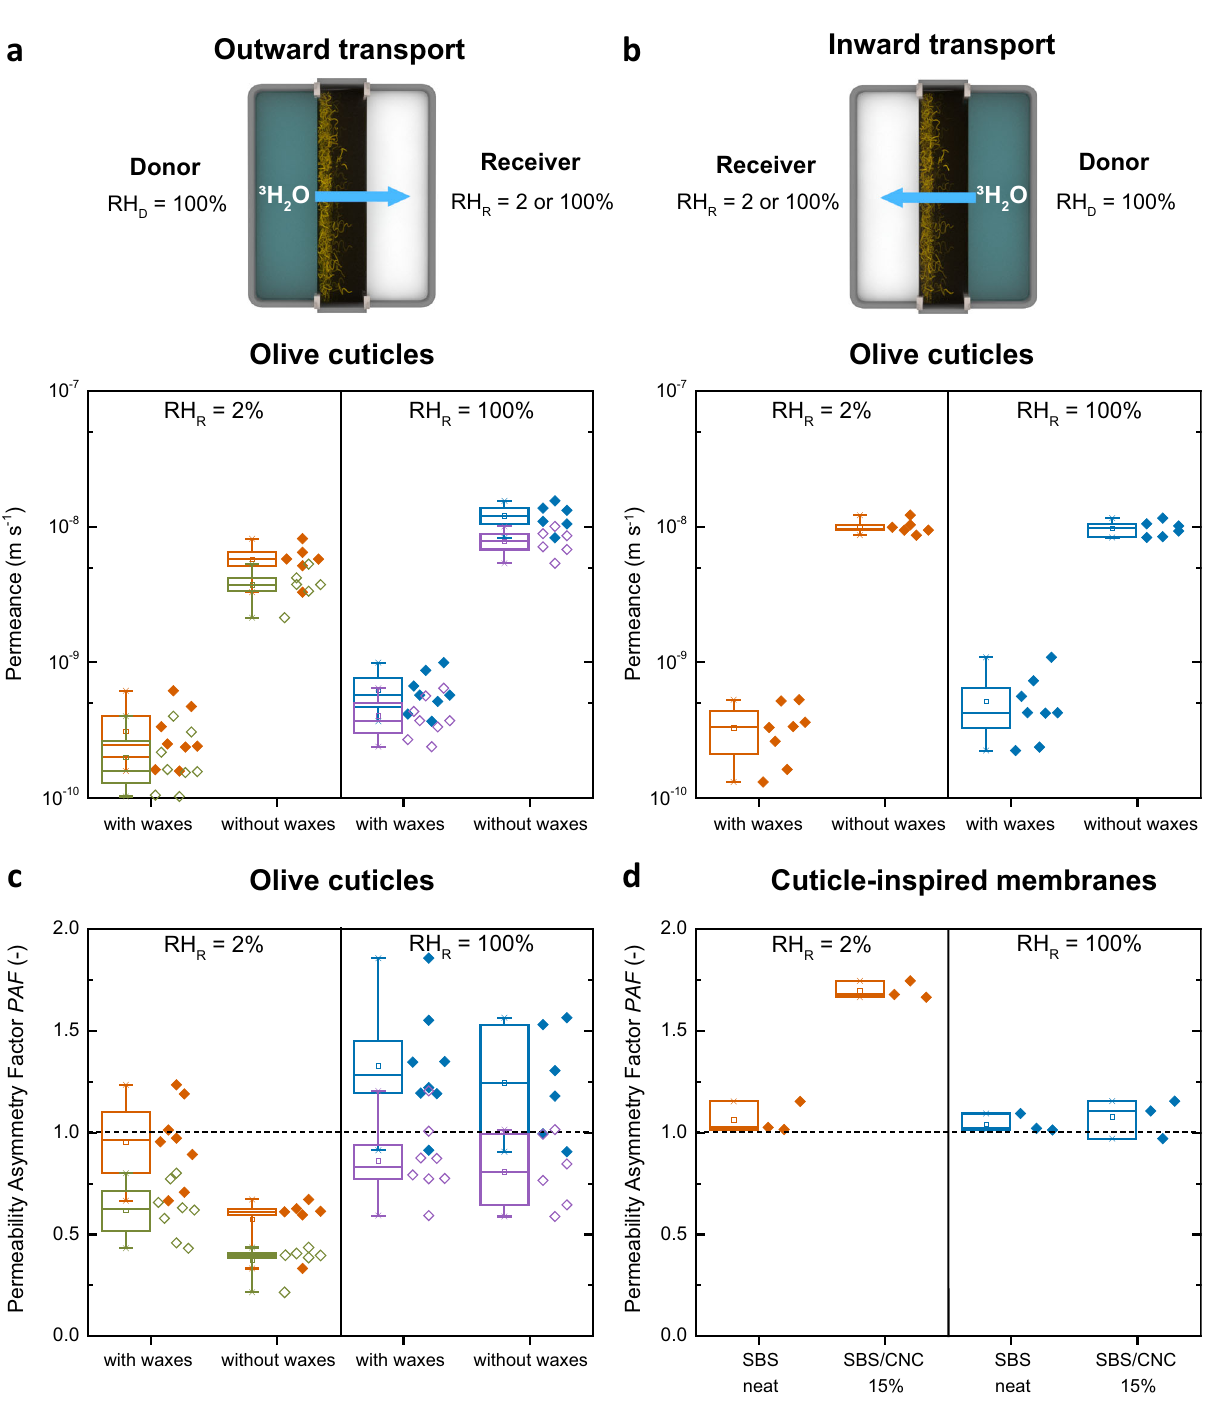
Fig. 4 Water transport through olive cuticles and cuticle-inspired membranes measured by radiolabeled 3 H 2 O permeation tests. a , b Schematics (not to scale) of the measurement con fi gurations and box plots showing the outward and inward transport of 3 H 2 O through olive cuticles with and without waxes under varying relative humidity conditions at the receiver (RH R = 2 or 100%) and membrane orientations. The geometry was varied so that a the inner cuticular side (outward transport) and b the outer cuticular side (inward transport) faced the donor (RH D = 100%). Permeances were calculated assuming the inner cuticular side as fl at (solid orange and blue symbols and boxes) or rough (open green and purple symbols and boxes). c , d Box plots of the permeability asymmetry factor PAF of c ~20 μ m olive cuticles and of d ~33- μ m-thick membranes of SBS or SBS/CNC containing 15 wt% CNCs determined by 3 H 2 O permeation experiments with the CNC-rich bottom side and the top side facing the donor (RH D = 100%). In all box charts, whiskers extend to min and max values, box edges show 25 – 75 percentiles, center line represents median, and hollow square represents mean. The experiments were conducted at 25 °C with n = 8 (olive with waxes), n = 6 (olive without waxes), and n = 3 (SBS neat, SBS/CNC 15%) different